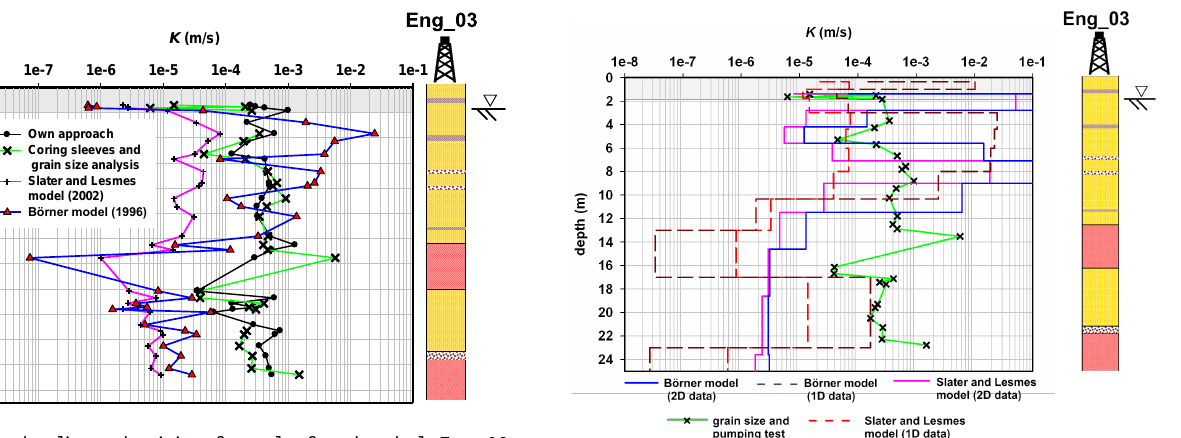
218 Fig. 10. Hydraulic conductivity of samples from borehole Eng_03. Fig. 10. Hydraulic conductivity of samples from borehole Eng_03. Black line: own approach. 219 Black line: own approach. Green line: from coring sleeves and grain Green line: from coring sleeves and grain size analysis using Kozeny equation. Pink line: from 220 Slater and Lesmes (2002) model. Blue line: from Börner et al. (1996) model. 221 size analysis using Kozeny equation. Pink line: from the Slater and 222 Lesmes (2002) model. Blue line: from the Börner et al. (1996) model.